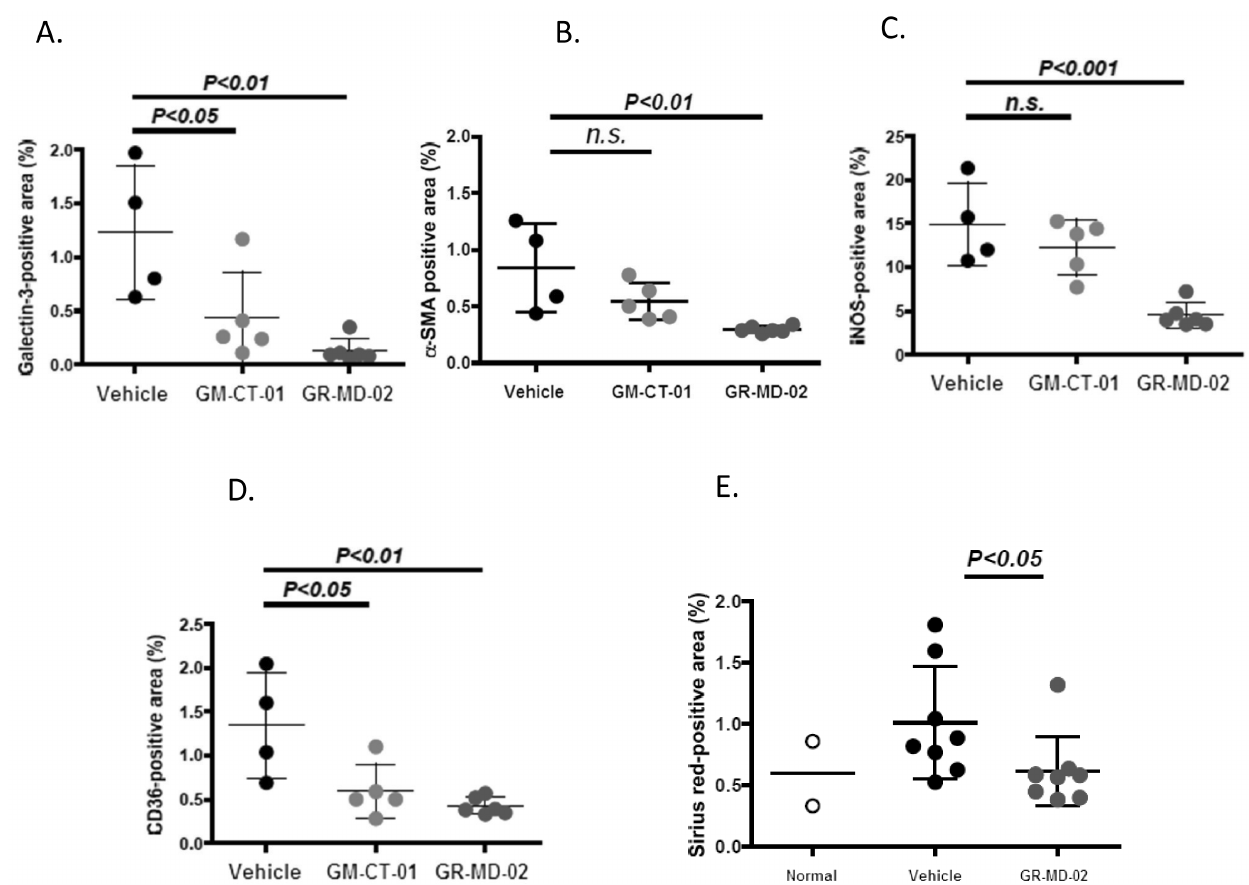
Figure 7. Quantitative analysis of immunohistochemistry and histology. Experiments from Figure 6 and 8. A : Gal-3 positive area; B : a - SMA positive area; C : CD36 positive area; D : iNOS positive area; E : Sirius red positive area of kidney sections from experiment in figure 8. Differences between the vehicle group and the treatment groups were assessed by one way ANOVA followed by Bonferroni Multiple P values , 0.05 were considered significant and results expressed as mean 6 SD.